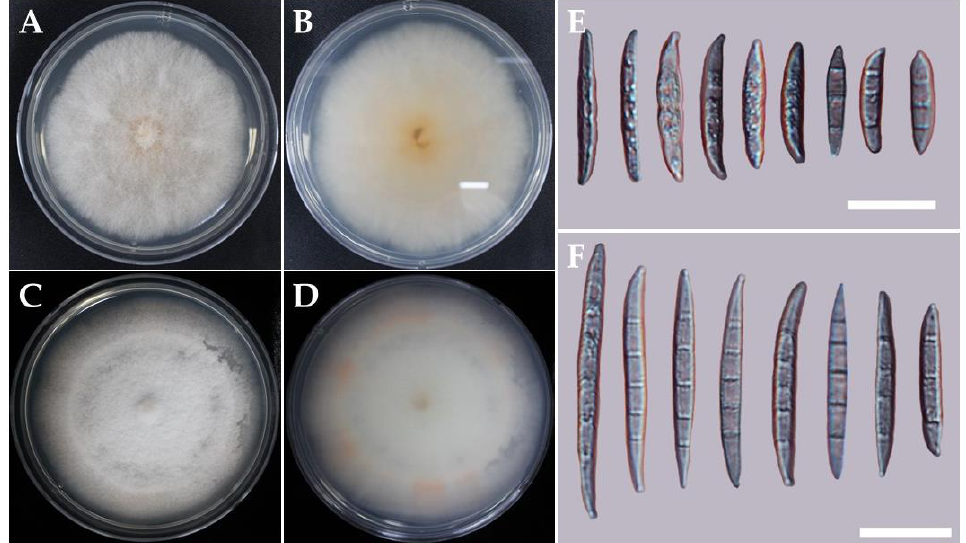
Figure 4. Colony morphology of the isolates of CMML20 – 12 and CMML – 13 on PDA at 25° C for 7 days ( A – D ). Different conidial sizes and shapes are observed under the microscope ( E , F ). Scale bars ( E , F ) = 20 μm.